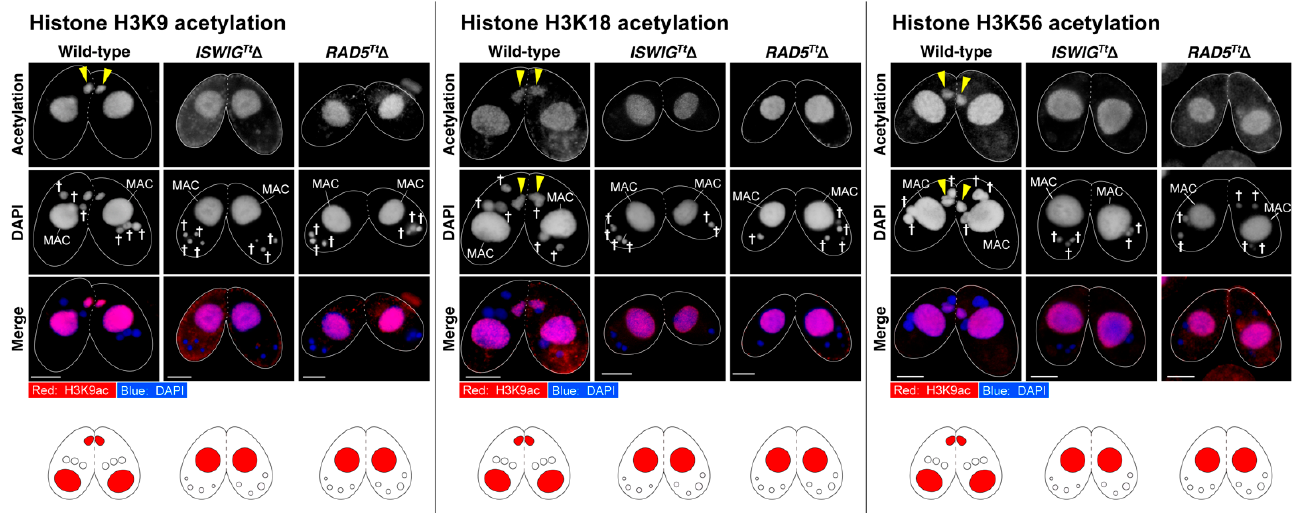
Figure 5. Signals for H3K9ac, H3K18ac, and H3K56ac appeared in the selected hMIC in which γ - H2AX dephosphorylation took place in the wild-type pair. In contrast, none of the hMIC underwent Histone H3 acetylation in the ISWIG Tt Δ pairs and the RAD5 Tt Δ pairs in which hMIC selection failed. Schematic diagrams for acetylated Histone H3 are shown below each micrograph set. Triangle—the selected hMIC; †—unselected hMIC; The scale bar denotes 10 μ m.